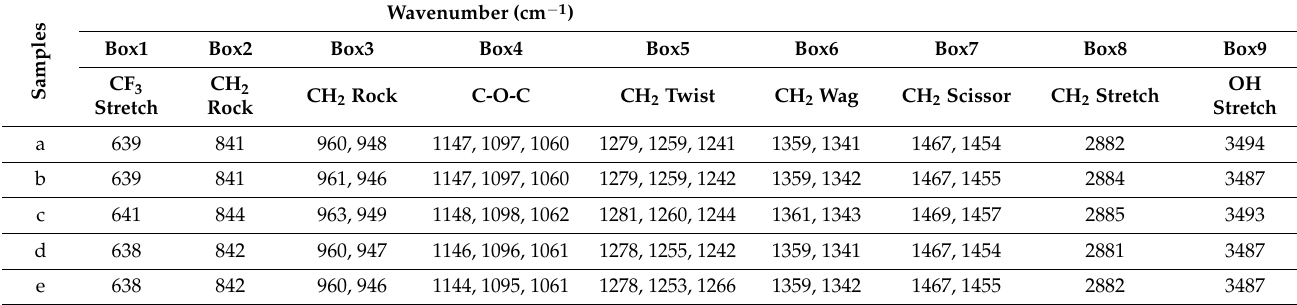
Table 2. The assignment of each wavenumber of FT-IR spectrum in Figure